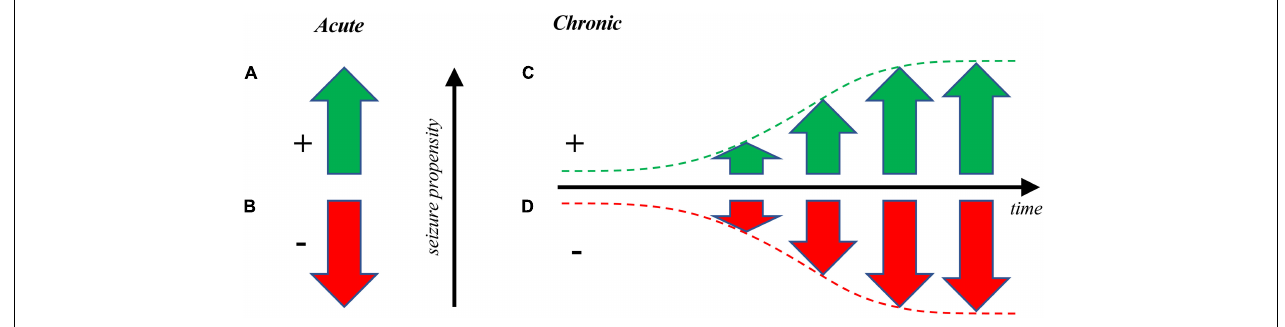
FIGURE 1 | Optogenetic manipulation of seizure propensity. (A) Optogenetics can be used to drive seizures acutely (Khoshkhoo et al., 2017) or to (B) put a brake on already active seizures (Wykes et al., 2012; Krook-Magnuson et al., 2013) as a form of pro- or anti-convulsant, respectively. This latter approach has potential clinical applications for interrupting ongoing seizures (Paz et al., 2013), whereas both are useful for studying epilepsy. (C) Seizures can also be gradually elicited over time via optogenetic kindling, or optokindling (Cela et al., 2019). Optokindling is fundamentally distinct from directly driving seizures by optogenetic stimulation, since optokindling requires long-lasting changes of neuronal circuits (Cela et al., 2019), whereas direct optogenetic drive does not (Khoshkhoo et al., 2017). (D) It may also be possible to gradually decrease seizure propensity via optogenetic dekindling. As far as we know, this remains to be experimentally demonstrated optogenetically, but such findings have been reported with electrical stimulation (Bains et al., 1999; Ozen and Teskey, 2009). The kindling and dekindling modes may both enable the study of epileptogenesis, e.g. to test therapies that slow down or reverse the development of